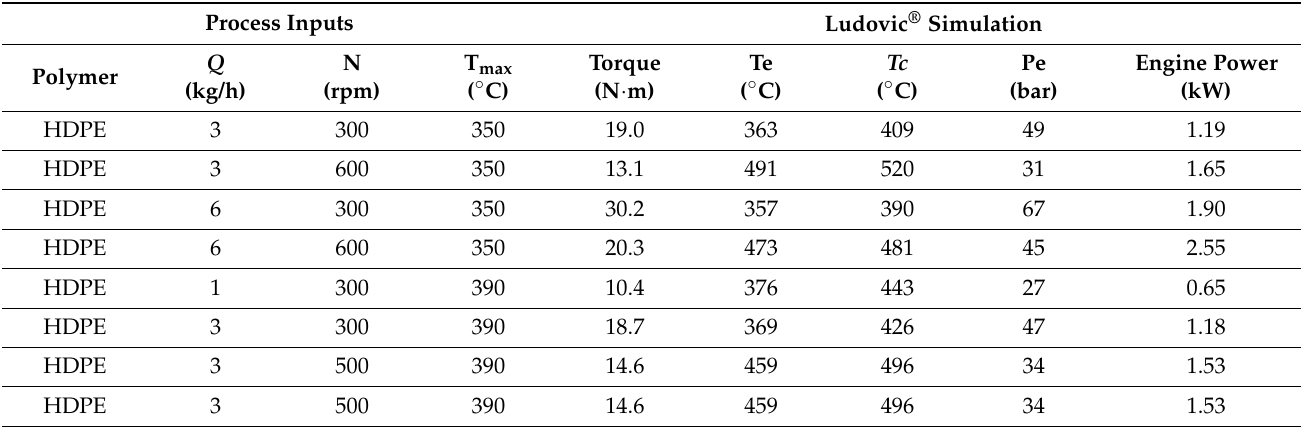
Table A2. Ludovic ® results obtained for the different tested extrusion